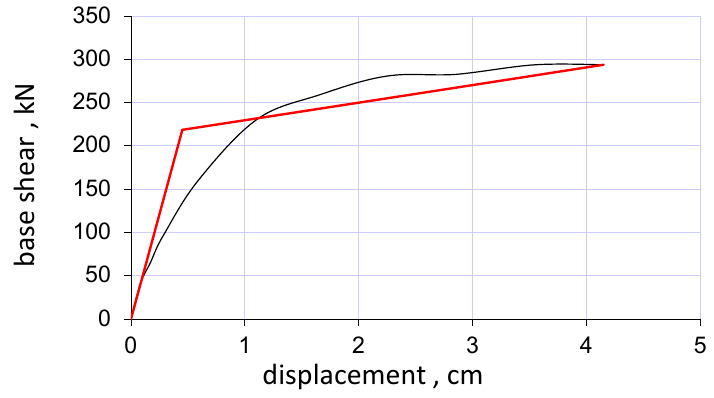
Figure 20. The two-line graph resulting from the cyclic loading curve.